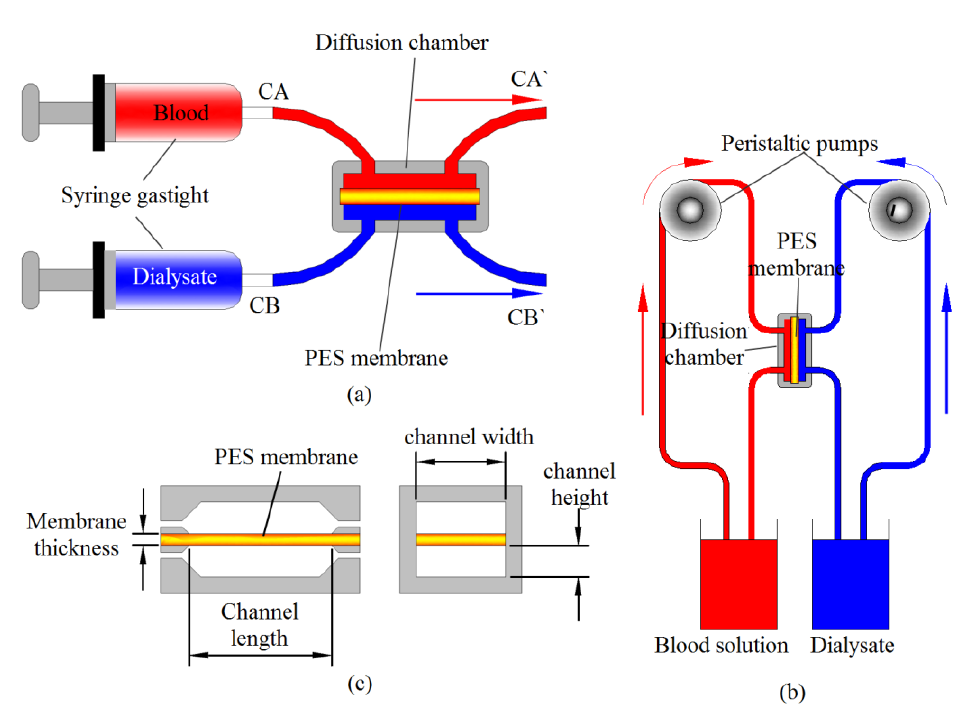
Figure 1. Diffusion test set up: ( a ) short term diffusion test setup; ( b ) long term diffusion test setup; ( c ) parameters used in diffusion coefficient